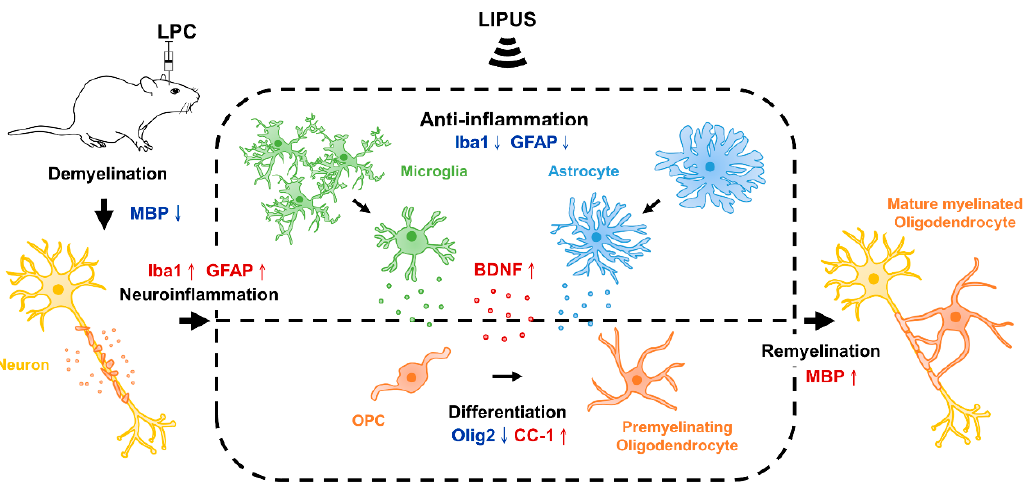
Figure 5. The schematic diagram indicates the potential mechanism through which LIPUS treat- ment enhances remyelination in a LPC-induced model of demyelination in the hippocampus. Several resident cells impact remyelination after LIPUS treatment, including microglia, astrocytes, oligodendrocyte progenitor cells (OPCs), and oligodendrocytes. Our results demonstrate that LIPUS treatment promotes remyelination in the demyelination lesion. These effects are related to increased expression levels of BDNF and MBP and the inhibition of glial cell activation in LPC-induced demyelination. ↑ and ↓ denote increased and decreased expression, respectively. LPC: lysolecithin, LIPUS: low-intensity pulsed ultrasound, BDNF: brain-derived neurotrophic factor, and MBP: myelin basic